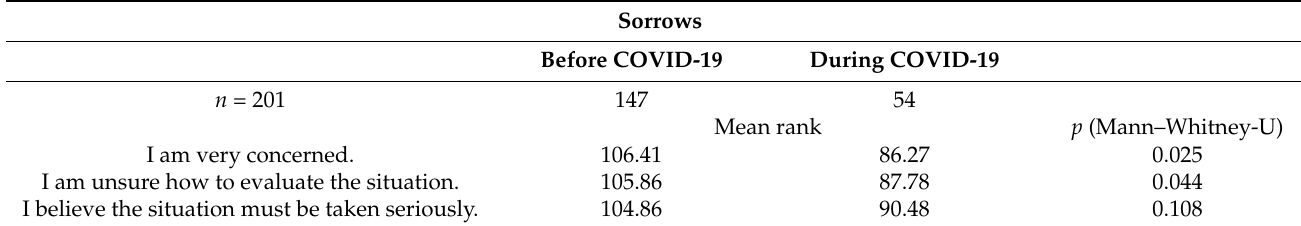
Table 2. Sorrow scale testing and results in parents counseled before and during the pandemic.